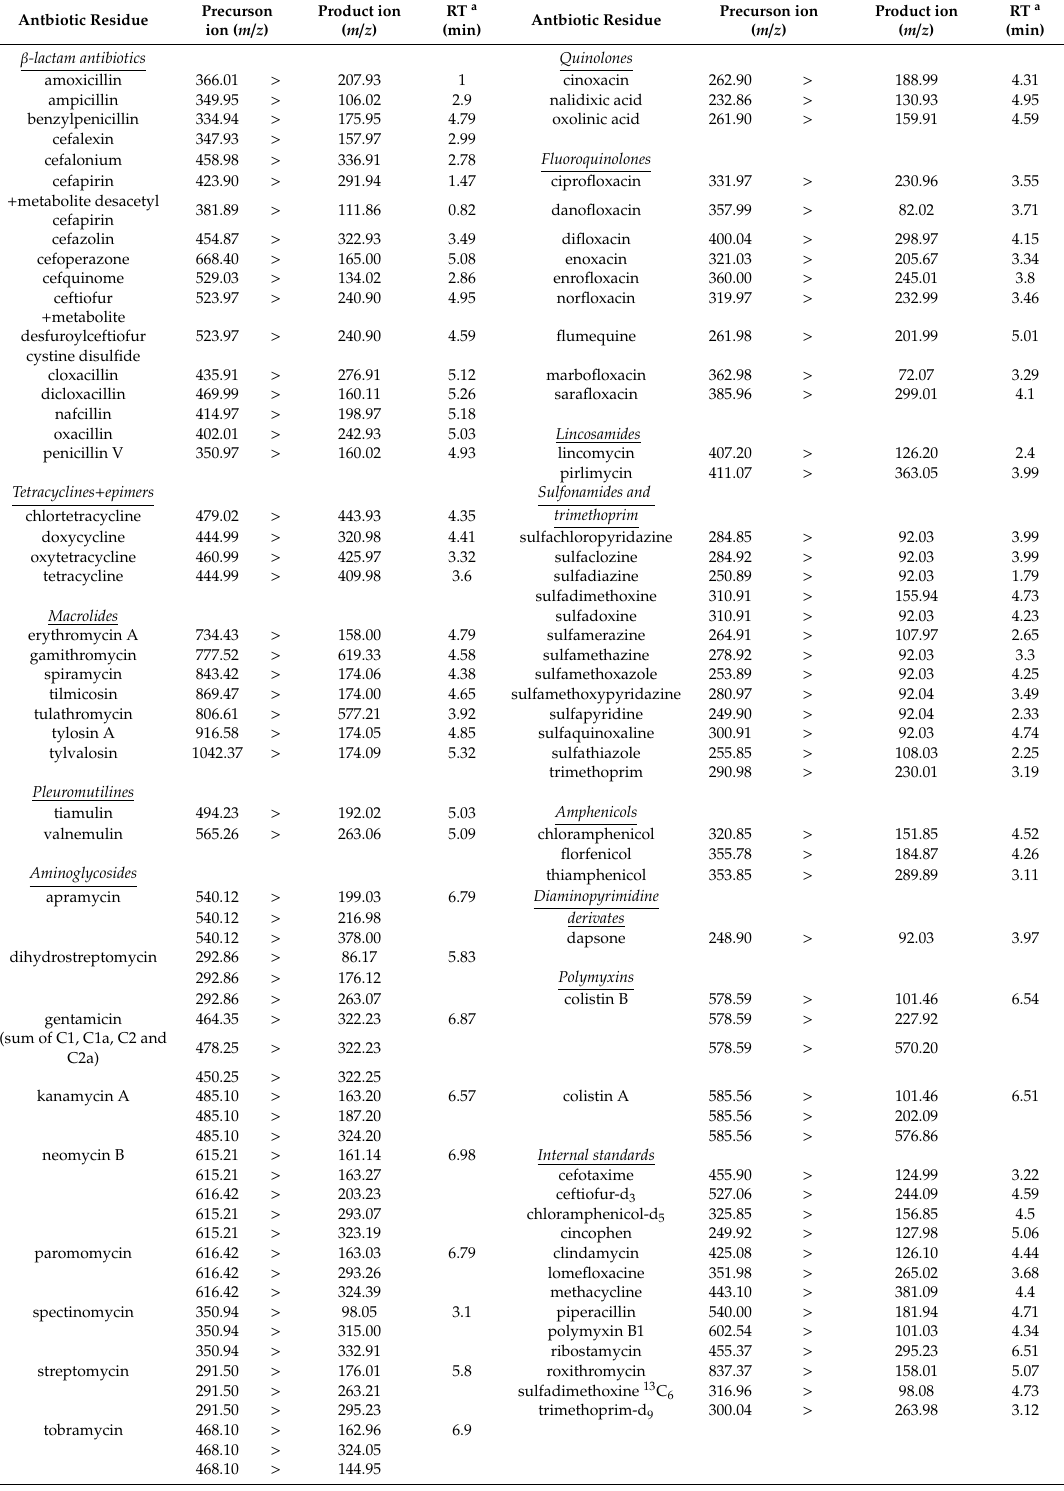
Table 7. Overview of the antibiotics screened for in the pig